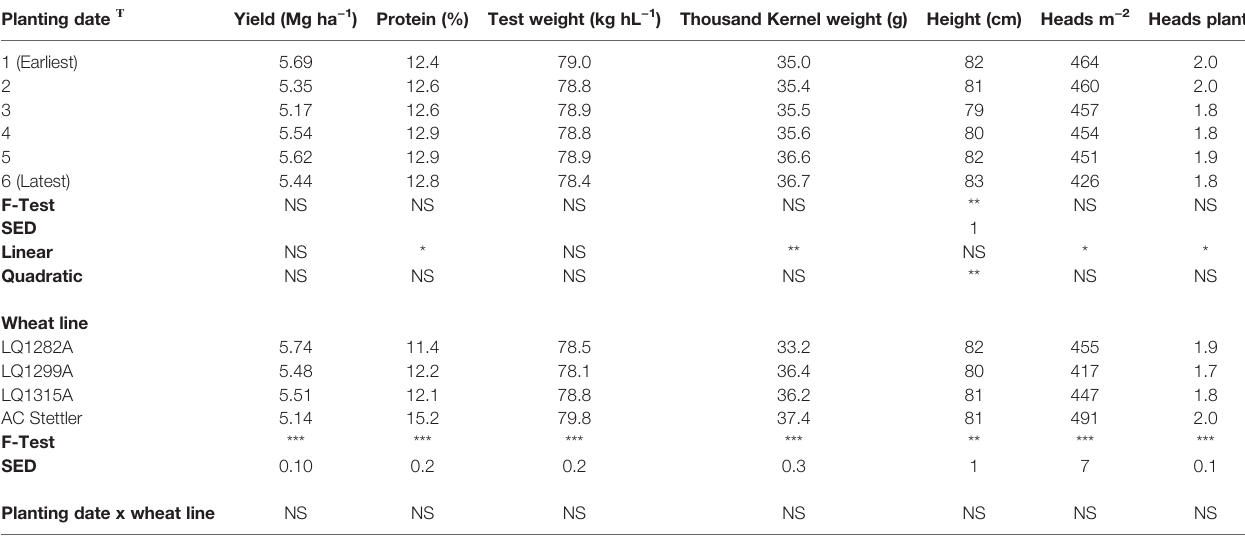
TABLE 6 | Least square means values and signi fi cance of treatment interactions for sites north of 51°N latitude. Planting date